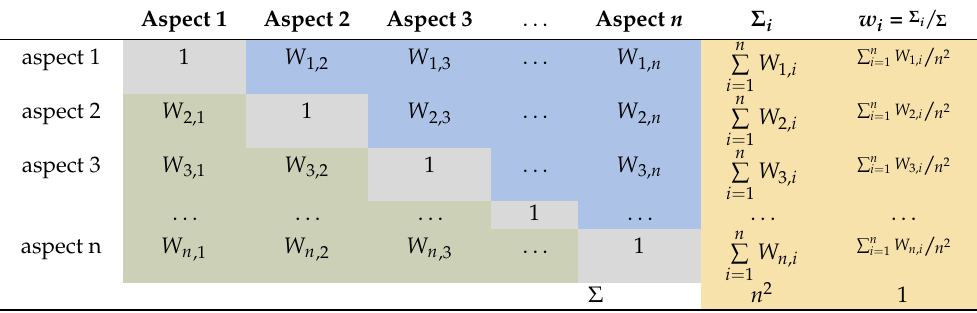
Table 3. Pairwise comparison for four